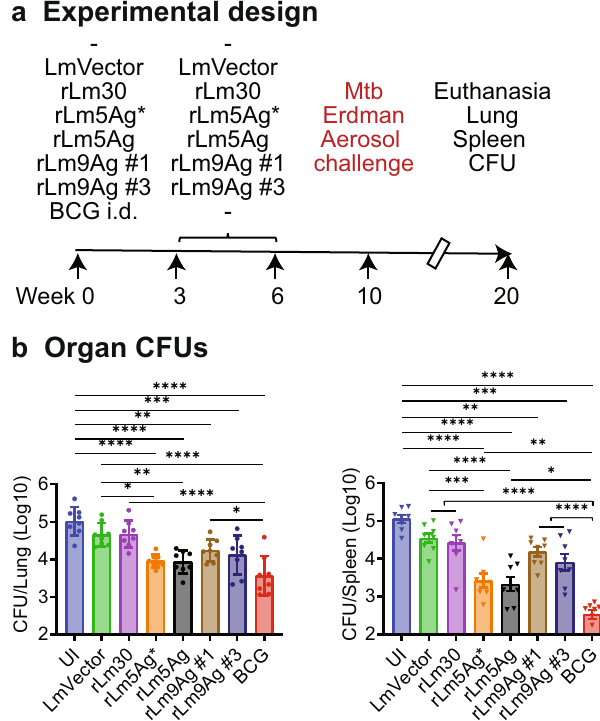
Fig. 8 Ef fi cacy of immunization with rLm5Ag and rLm9Ag vaccines against Mtb aerosol challenge in BALB/c mice. a BALB/c mice ( n = 8/ group) were unimmunized (UI), vaccinated i.d. with 5 × 10 5 CFU BCG at Week 0, or vaccinated s.q. three times with LmVector, rLm30, rLm5Ag* (combination of rLm30 + rLm4Ag), rLm5Ag (a single vaccine expressing the same 5 Mtb antigens as rLm5Ag*), or rLm9Ag (clones #1 and #3) at Weeks 0, 3, and 6. The mice were then challenged at Week 10 with aerosolized Mtb Erdman strain (average of 10 CFU delivered to the lungs of each animal, as assayed at Day 1 post challenge) and euthanized at Week 20. b . Afterwards, lungs (left) and spleens (right) were removed and assayed for bacillus burdens. Shown are means ± SEM. Each symbol represents one mouse. * P < 0.05; ** P < 0.01; *** P < 0.001; and **** P < 0.0001 by one-way ANOVA with Tukey ’ s multiple comparisons test (Prism). A similar experiment was repeated in C57BL/6